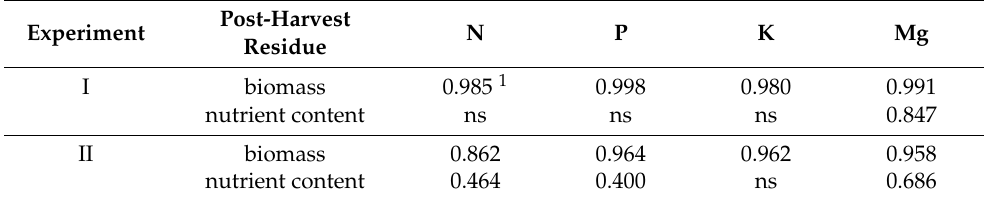
Table 3. Dependence of nutrient accumulation on nutrient content and post-harvest residue biomass volumes, simple correlation